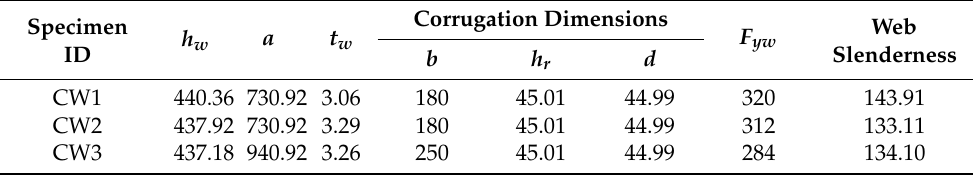
Table A3. Data of specimens tested by Johnson and Cafolla